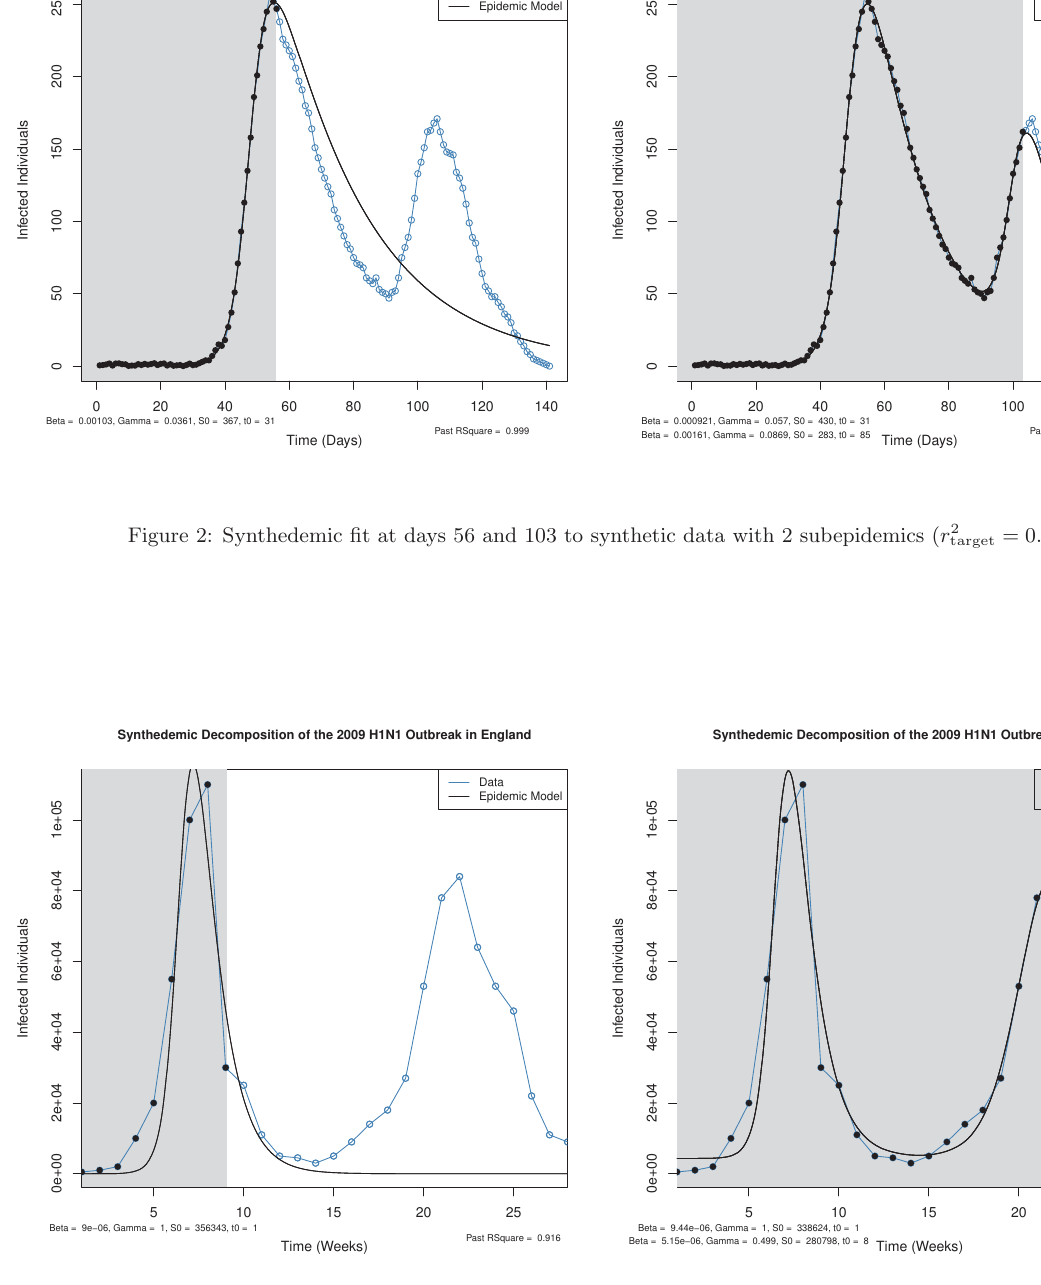
Figure 3: Synthedemic fit at weeks 9 and 22 to weekly Swine Flu reported cases in England during 2009 ( r 2 target = 0 .